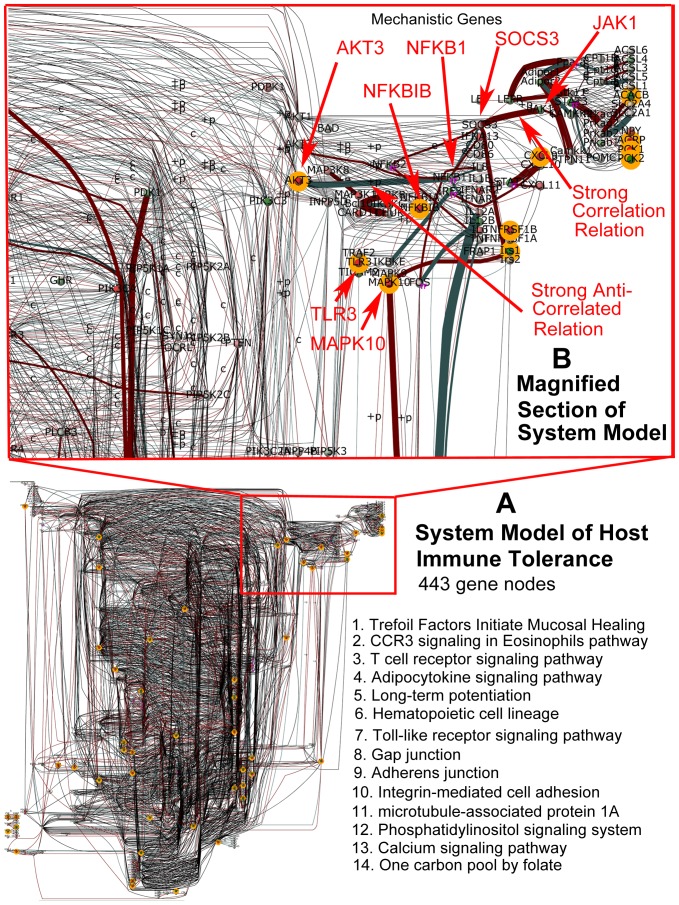
System Bayesian Network Model of Host Immune Tolerance.Fourteen pathways were used to construct the network developed from temporal in vivo host transcriptome data of MAP infected bovine Peyer's patch. The full network model is shown on the bottom figure. A magnified section of the model is shown in the top figure. Mechanistic genes are shown with orange rings. A few important mechanistic genes and arcs (gene-to-gene relationships) are indicated on the magnified view. The thickness of the arcs and their color indicates the strength of positive or negative correlation between the interconnected genes. Some of the pathway arcs are labled: +p = phosphorylation; −p = dephosphorylation; +u = ubiquitination; +m = methylation; e = expression;c = compound; and b = binding and unlabeled connecting arc implies activation.